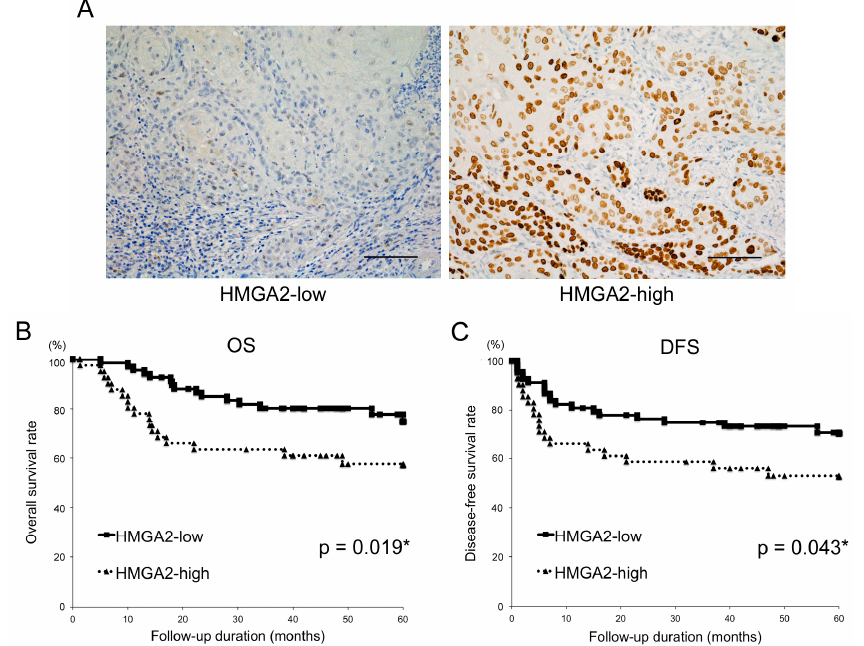
Figure 1. Tumor high-mobility group A protein 2 (HMGA2) expression status affects the survival rate of oral squamous cell carcinoma (OSCC) patients. ( A ) Immunohistochemical staining for HMGA2 in OSCC biopsy specimens. Representative microscopic images are shown according to expression status. Original magnification, ×200, scale bar = 100 μ m. ( B ) Based on Kaplan–Meier survival analysis of OSCC, the patients were divided into two groups based on HMGA2 immunostaining scores (low- or high-expression groups). Overall survival (OS) of the 110 OSCC patients based on the status of HMGA2 expression was determined. * p < 0.05. ( C ) Disease-free survival (DFS) of the 110 OSCC patients based on the status of HMGA2 expression. * p < 0.05.